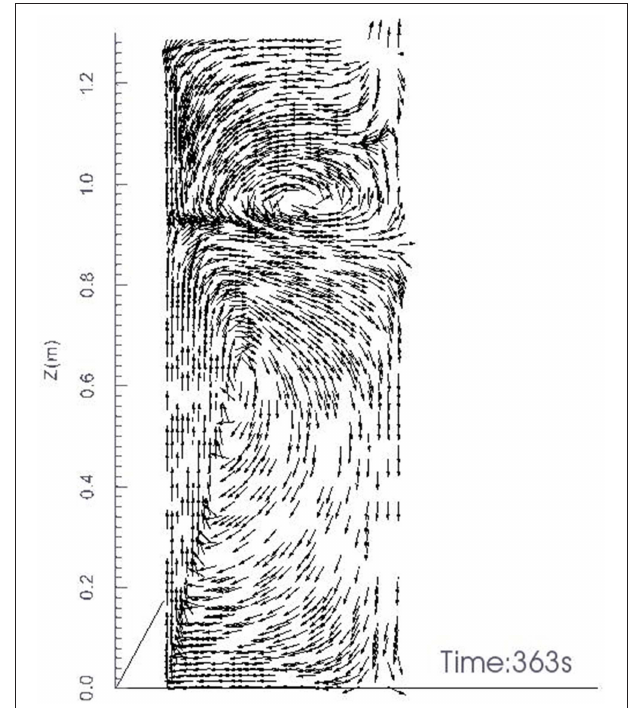
FIGURE 6 | Flow field at 362s.